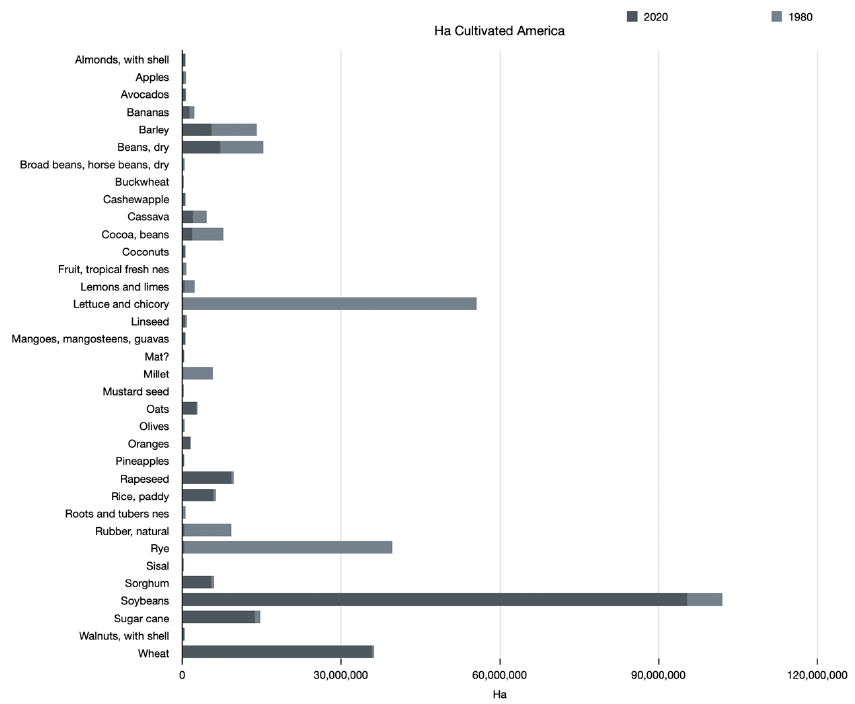
Figure 3. Crops production with an extension higher than 100,000 Ha in America, adapted from [25].